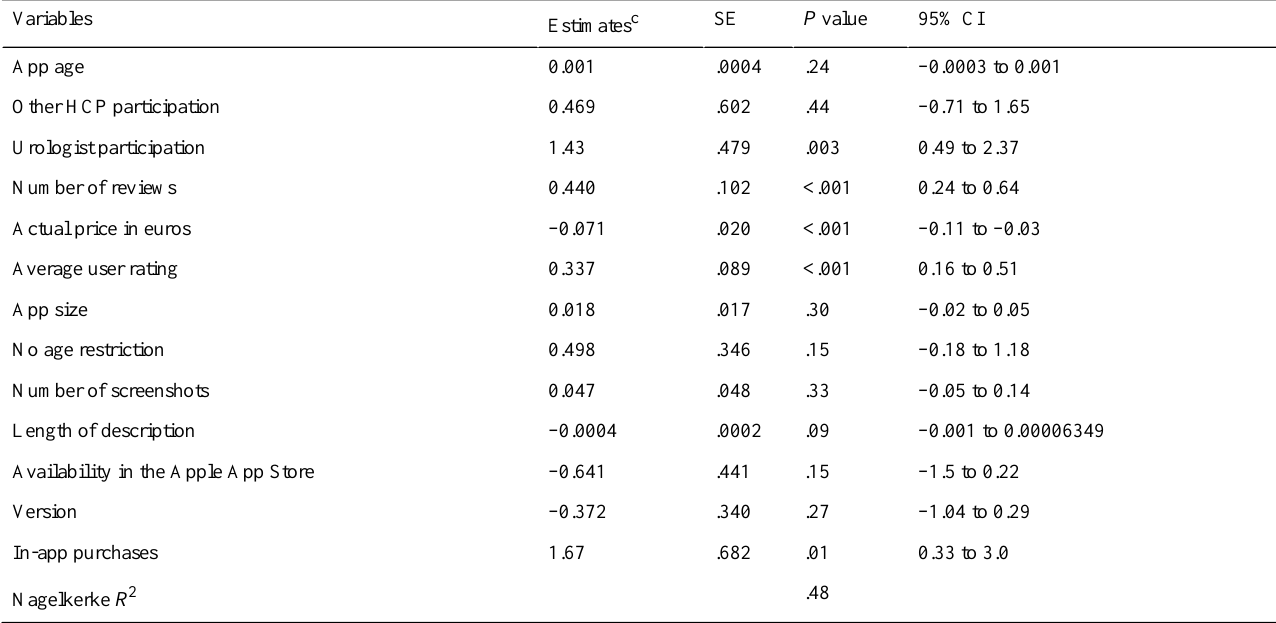
Table 4. Multivariate ordinal logistic regression of factors contributing to number of urology app downloads. a,b